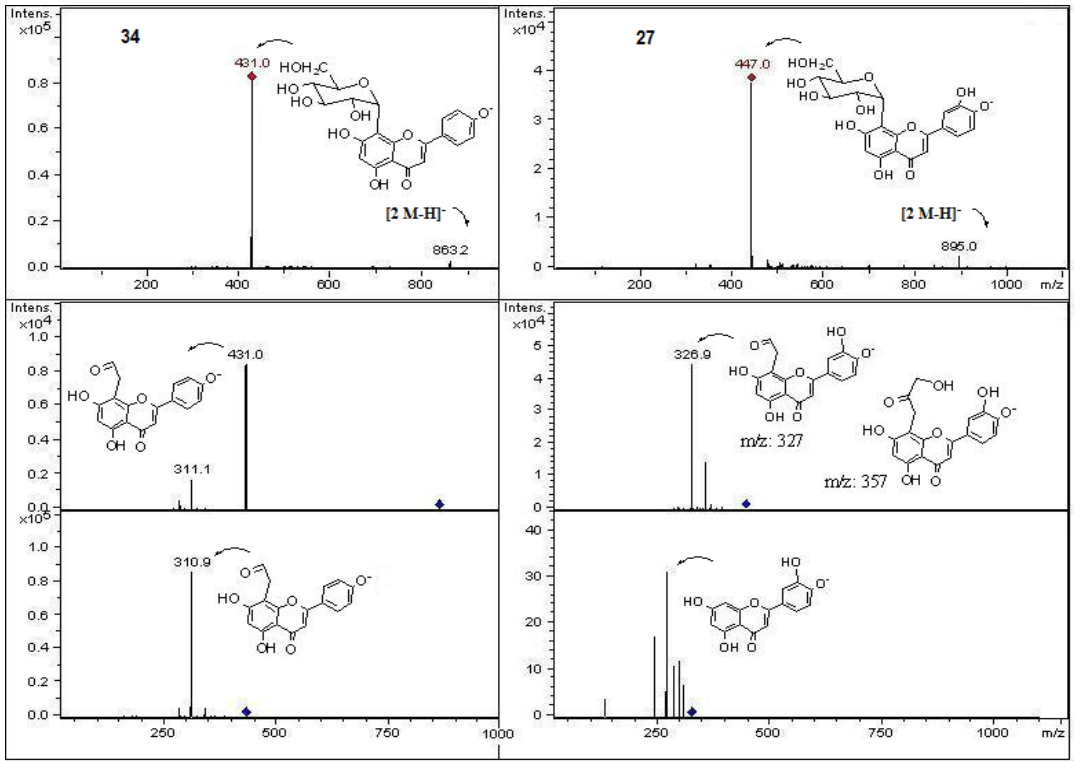
Figure 10. Structures, fragmentation, full ESI-MS and MS-MS spectra of peaks 27 and 34 .